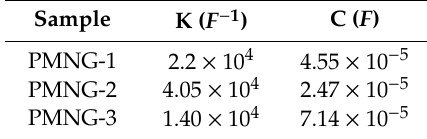
Table 3. The EEC fitting parameters for PVA:MC:NH 4 SCN:Gly systems at room temperature. Sample